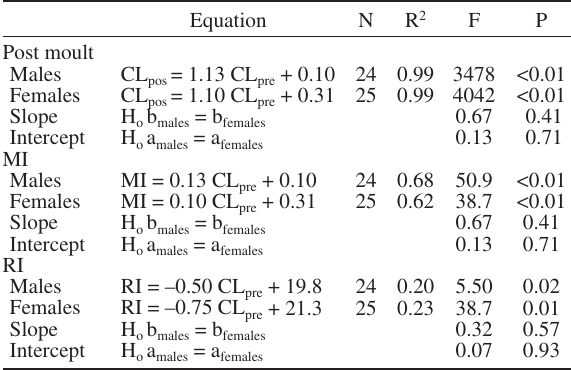
Table 1. – Results of the regression analysis for CL indicators CL , moult increments (MI) and relative increments pos (RI). Analysis of covariance to test differences between sexes. N, number of individuals; R 2 , determination coefficient; F, statistic F; P, probability; Significance level (P<0.05)